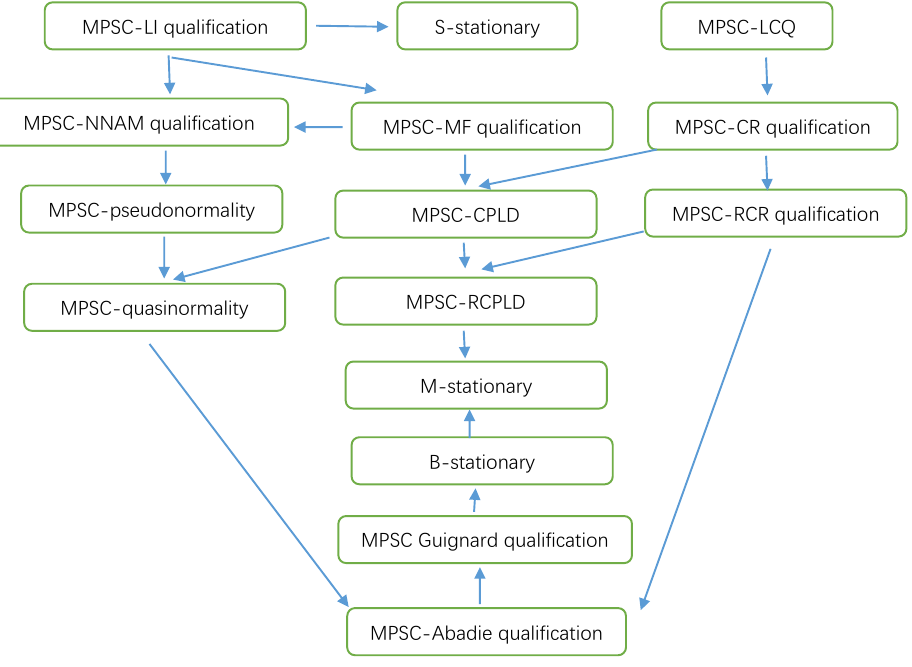
Figure 1. Relations between various